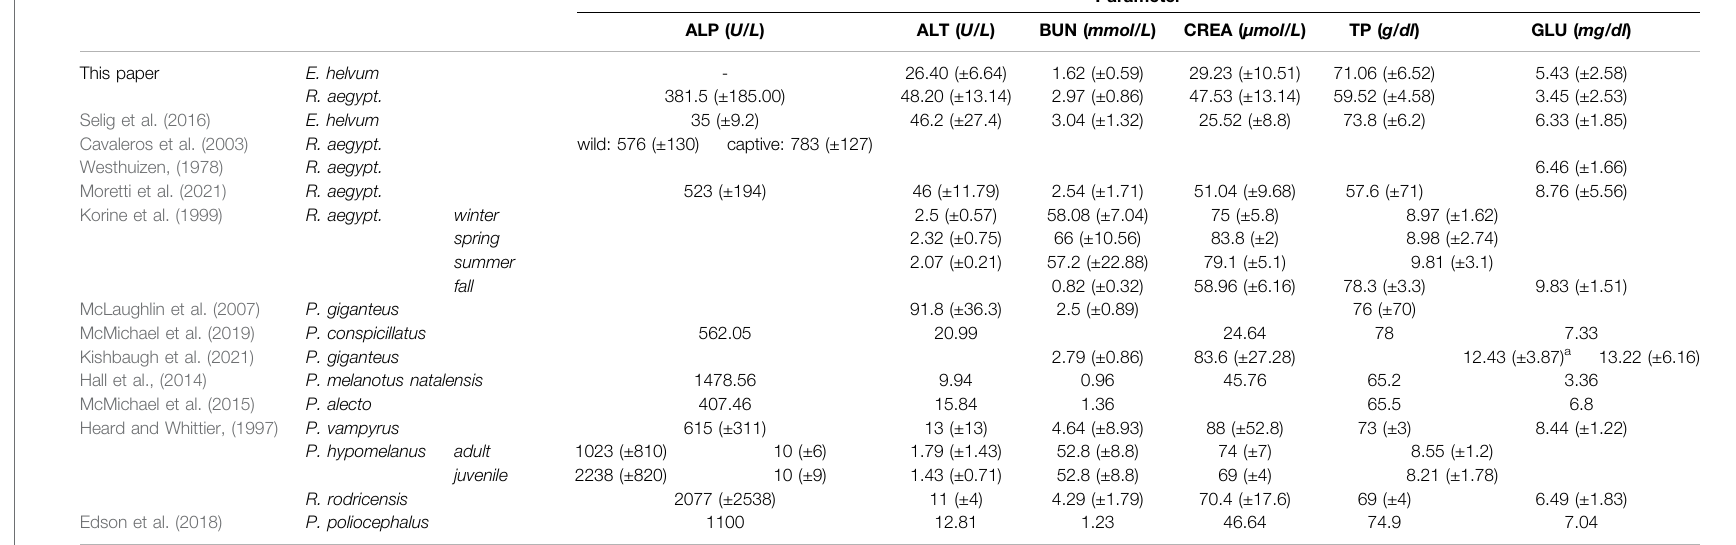
ALP, alkaline phosphatase; ALT, alanine-aminotransferase; BUN, blood urea nitrogen; CREA, creatinine; TP, total protein; GLU, glucose. All data are depicted as mean (standard deviation), if available. For comparison, units were adapted if needed. a Two different devices were used. b Averages of different populations were